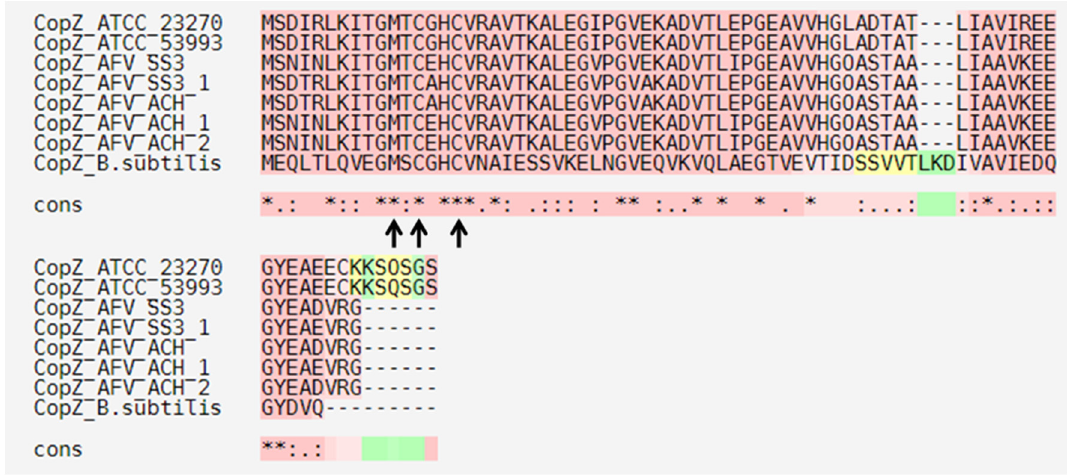
Figure 4. Amino acid sequence alignment of CopZ proteins identified in different copper-resistant microorganisms. Black arrows indicate the conserved MXCXXC motif that binds copper.